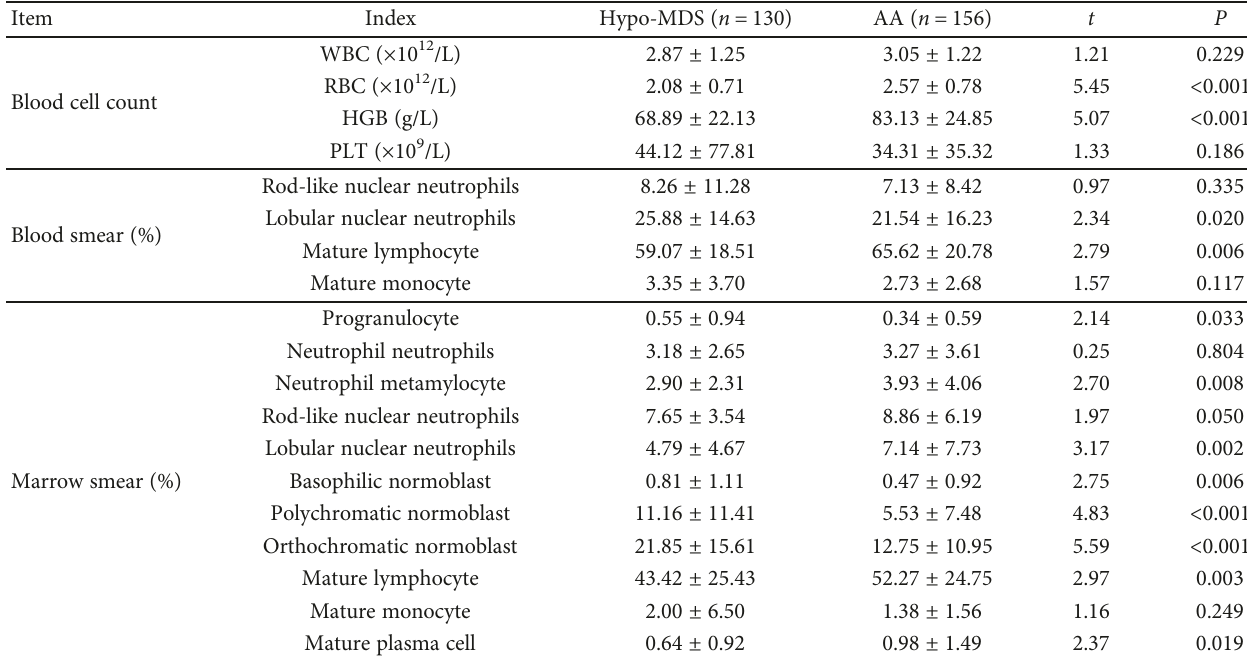
Table 2: Laboratory results ( x ± s